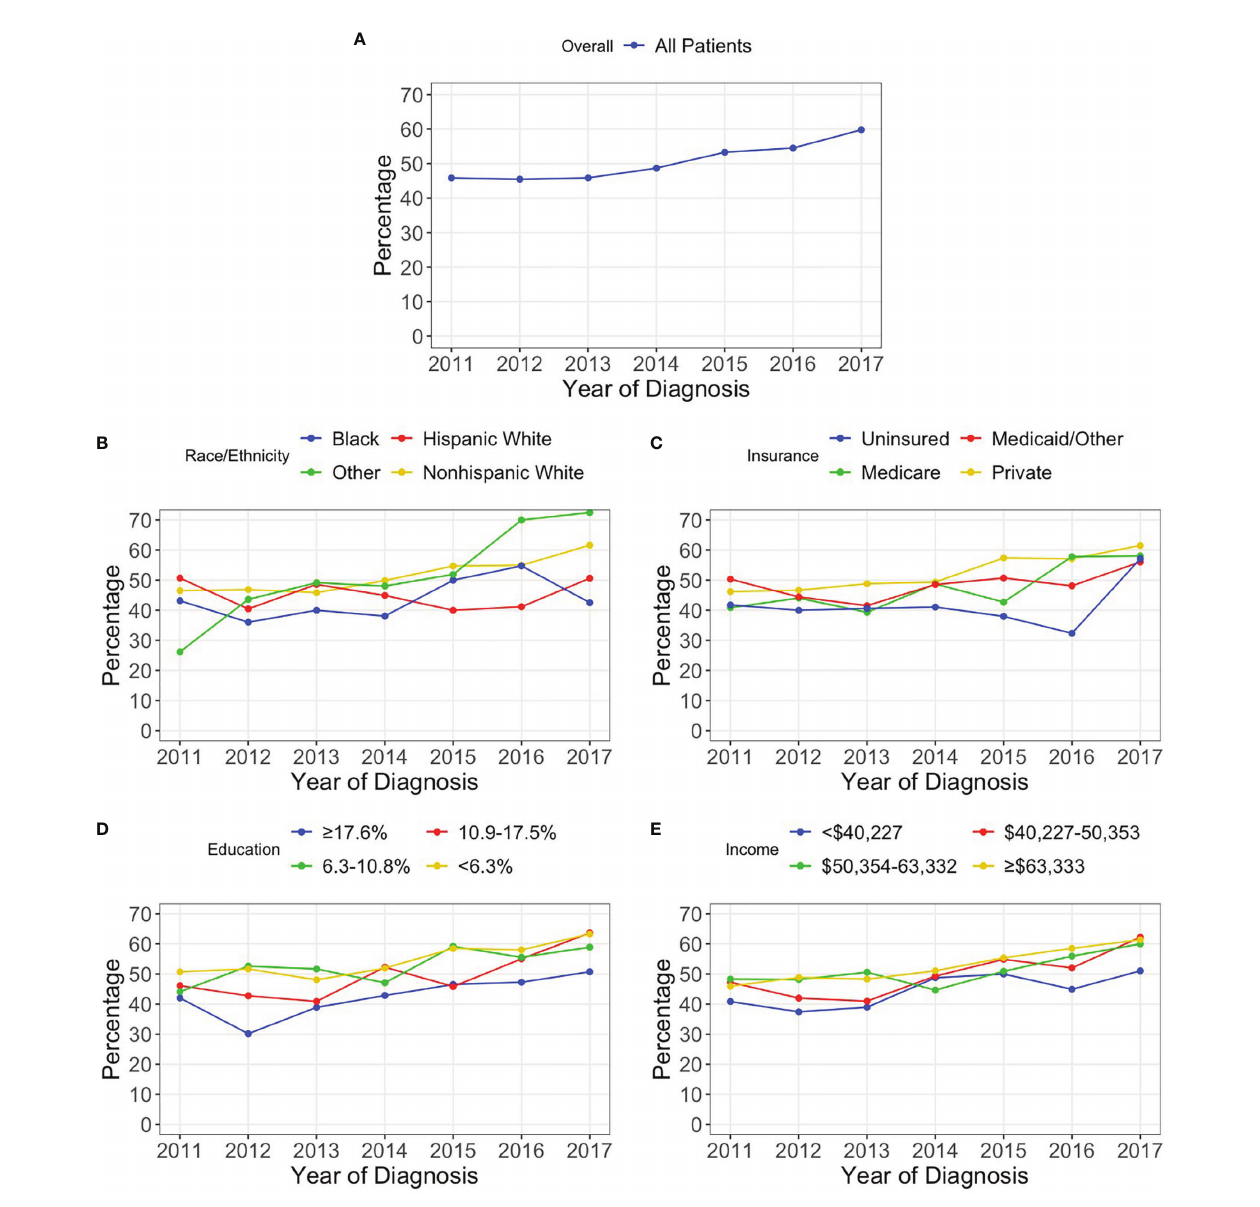
FIGURE 1 | Percentage of patients with a reported 1p/19q codeletion test for (A) all patients and strati fi ed by (B) race/ethnicity, (C) insurance status, (D) percentage of adults without a high school degree in patient ’ s zip code, and (E) median household income in patient ’ s zip